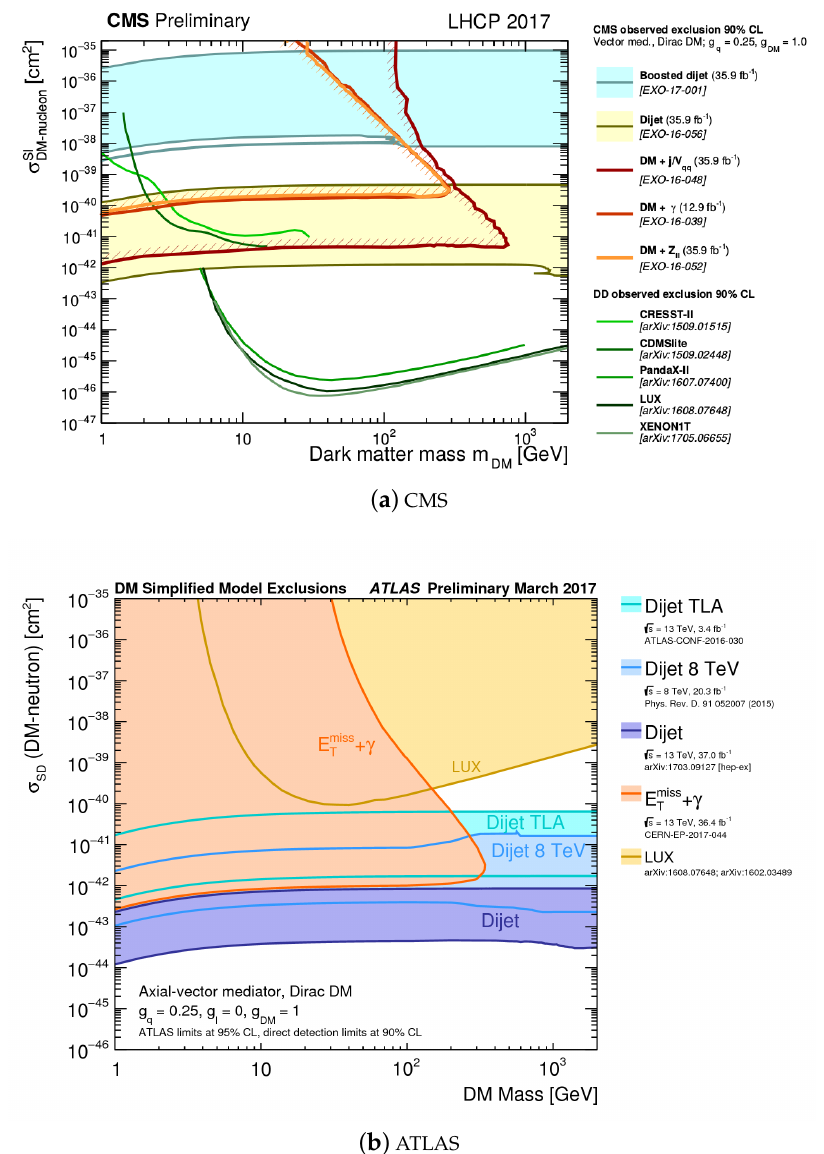
Figure 16. Summary of the reinterpretation of dark matter searches as the DM-nuclei scattering cross-section, for CMS [27] ( a ) and ATLAS [28] ( b ). The coupling of the mediator to DM (g DM ) is set to one, to quarks (g q ) to 0.25, and to leptons (g (cid:96) ) to zero. The CMS results refer to spin-independent (vector-mediator) scattering and the the ATLAS results to the spin-dependent (axial-vector) interaction. The results from some of the main direct-detection and indirect-detection searches are also shown for